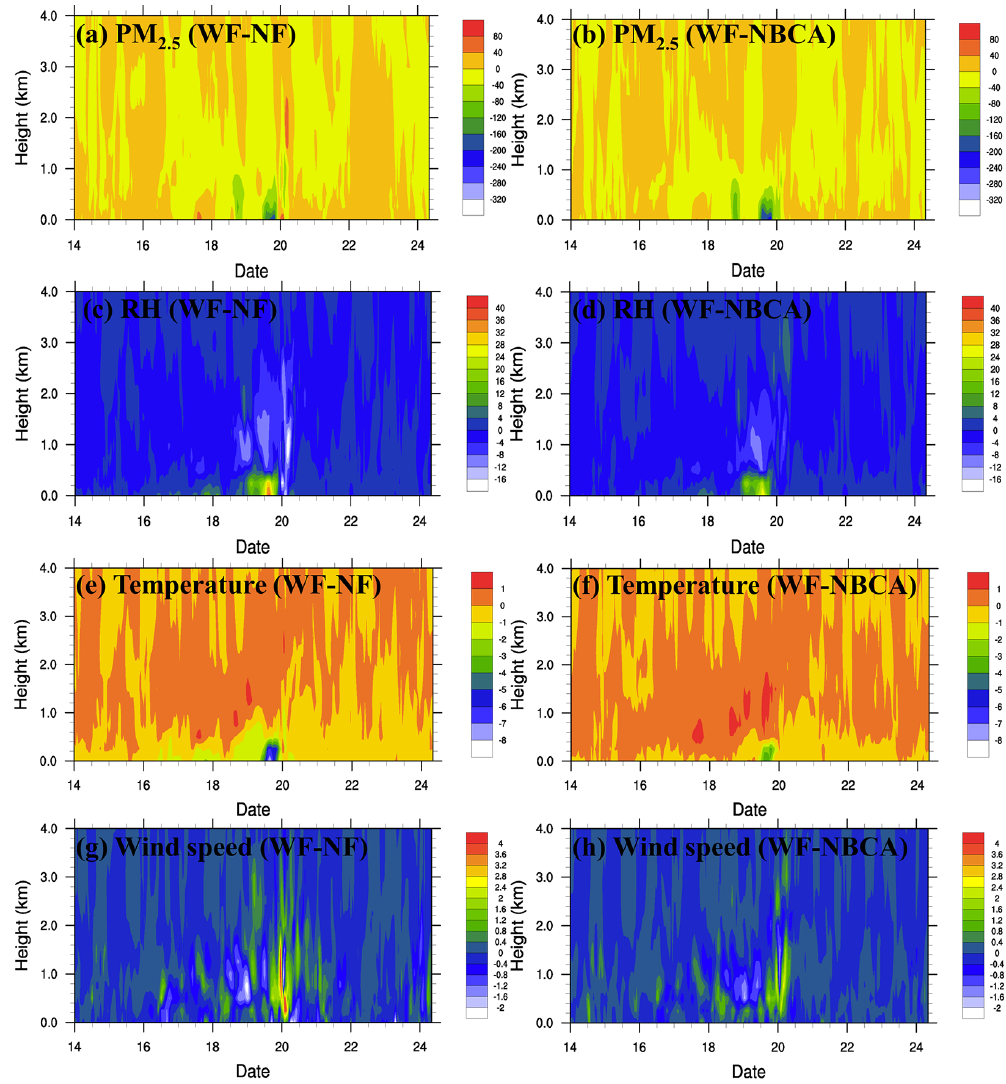
Figure 14. Temporal variations of vertical profiles of (a) PM 2 . 5 (unit: µgm − 3 , c ) RH (unit: %, e ) temperature (unit: ◦ C, g ) wind speeds (unit: ms − 1 ) differences in Beijing between WF and NF scenarios; (b) , (d) , (f) and (h) are PM 2 . 5 , RH, temperature and wind speeds differences in Beijing between WF and NBCA (BC absorptions are teased out)